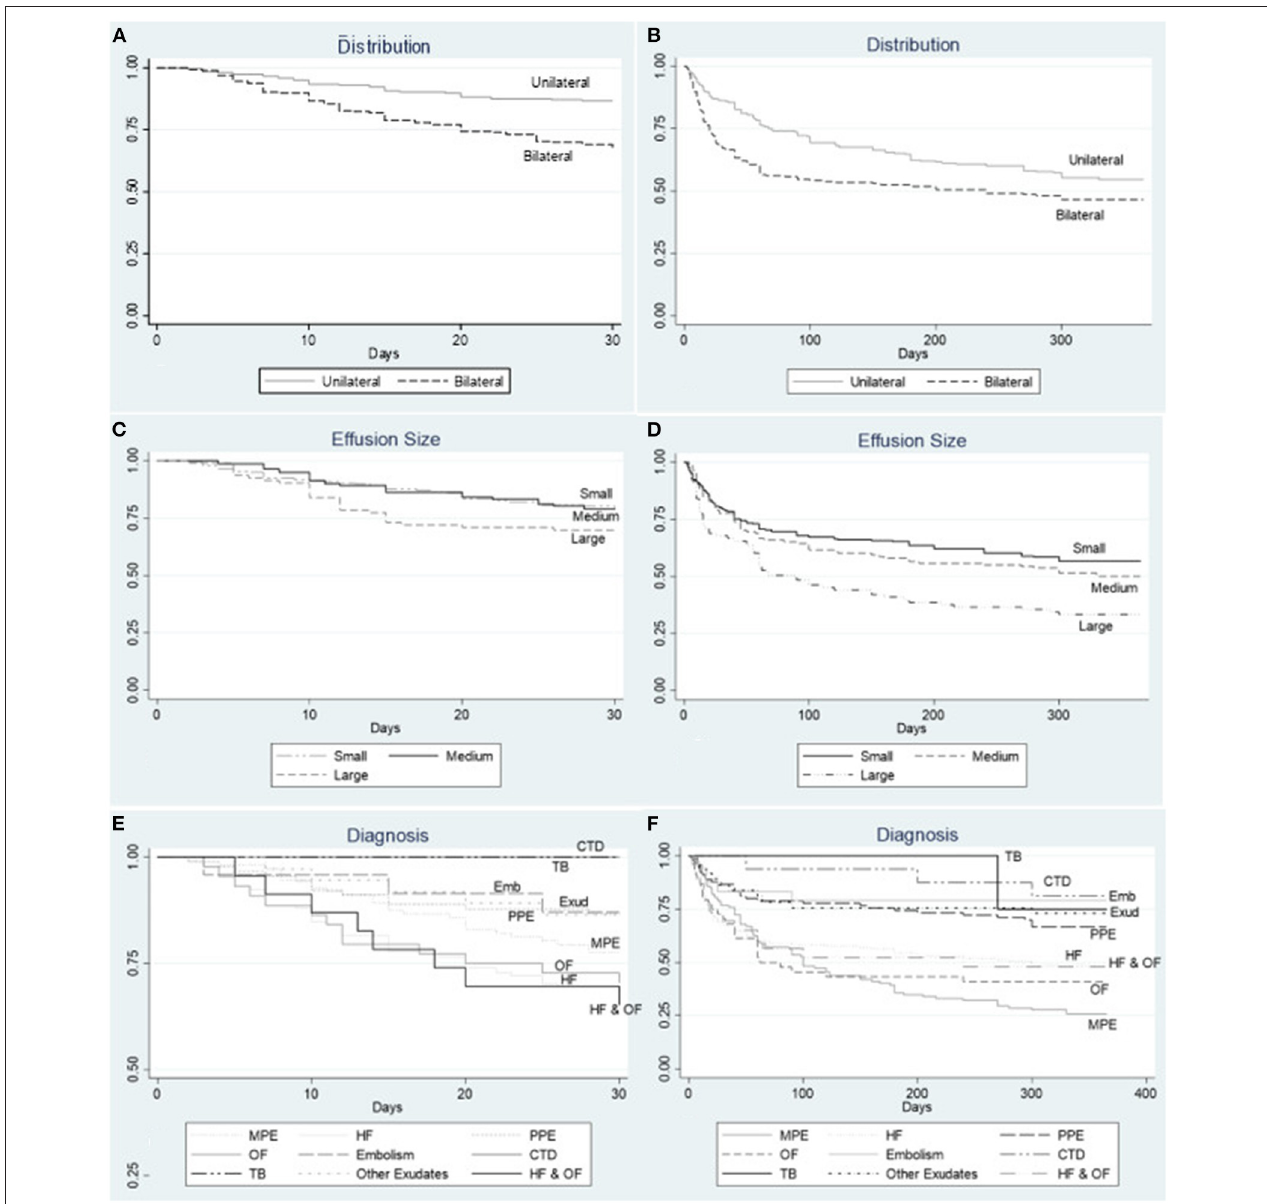
FIGURE 3 | Kaplan Meier survival curves at 1 month and 1 year by (A,B) distribution of PE. In both time periods, the presence of bilateral pleural effusion was associated with lower survival probability. (C,D) size of PE. In both time periods, the presence of large pleural effusion was associated with lower survival probability. (E,F) diagnosis of PE. Short-term survival is lower for patients with pleural effusions secondary to organ failure (heart, liver, renal) and multiple benign etiologies, while long-term survival is worse for patients with MPE. HF, heart failure; MPE, malignant pleural effusion; PPE, parapneumonic pleural effusion; CTD, connective tissue disease; Emb, pulmonary embolism; OF, organ failure; Exud, other exudate; TB, tuberculosis.